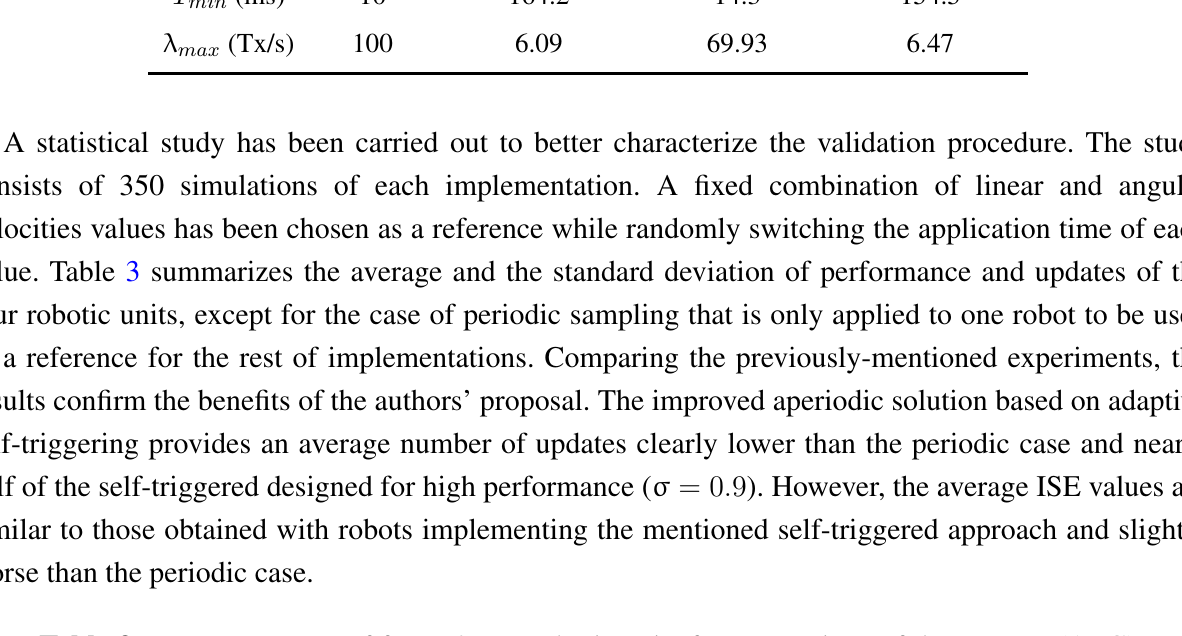
Table 3. Key parameters of four P3-DX robotic units for comparison of the average (AVG) and standard deviation (STD) values of 350 simulation results concerning the different control